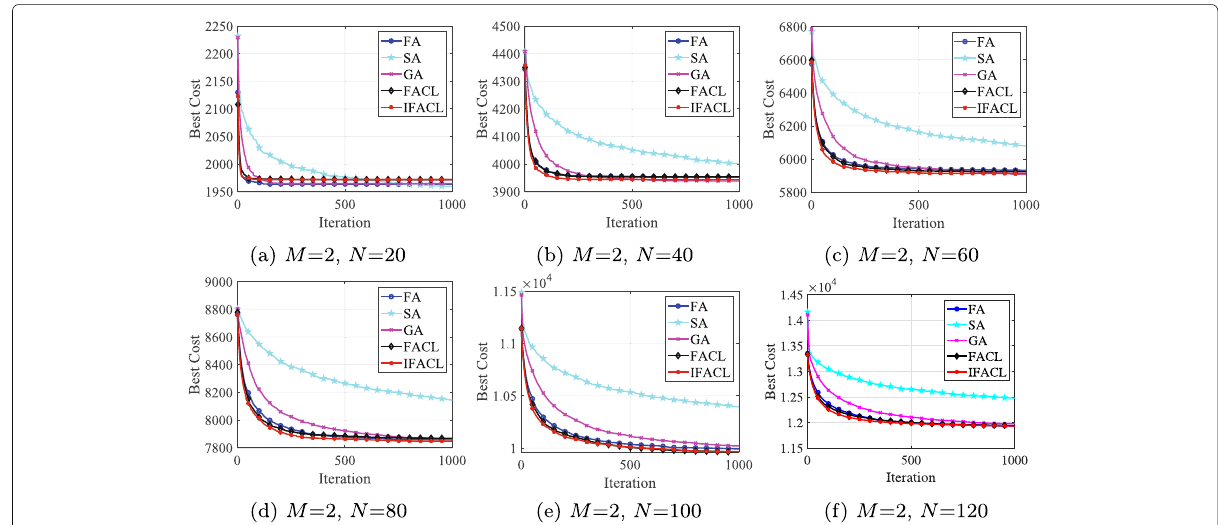
Fig. 6 Average convergence curve for each algorithm on PDominant instances of Dataset1 when the number of machines M =2